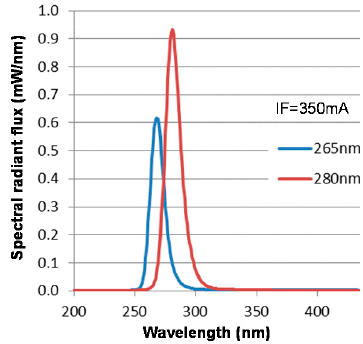
Figure 1. Spectral radiant flux of the DUV-LEDs.